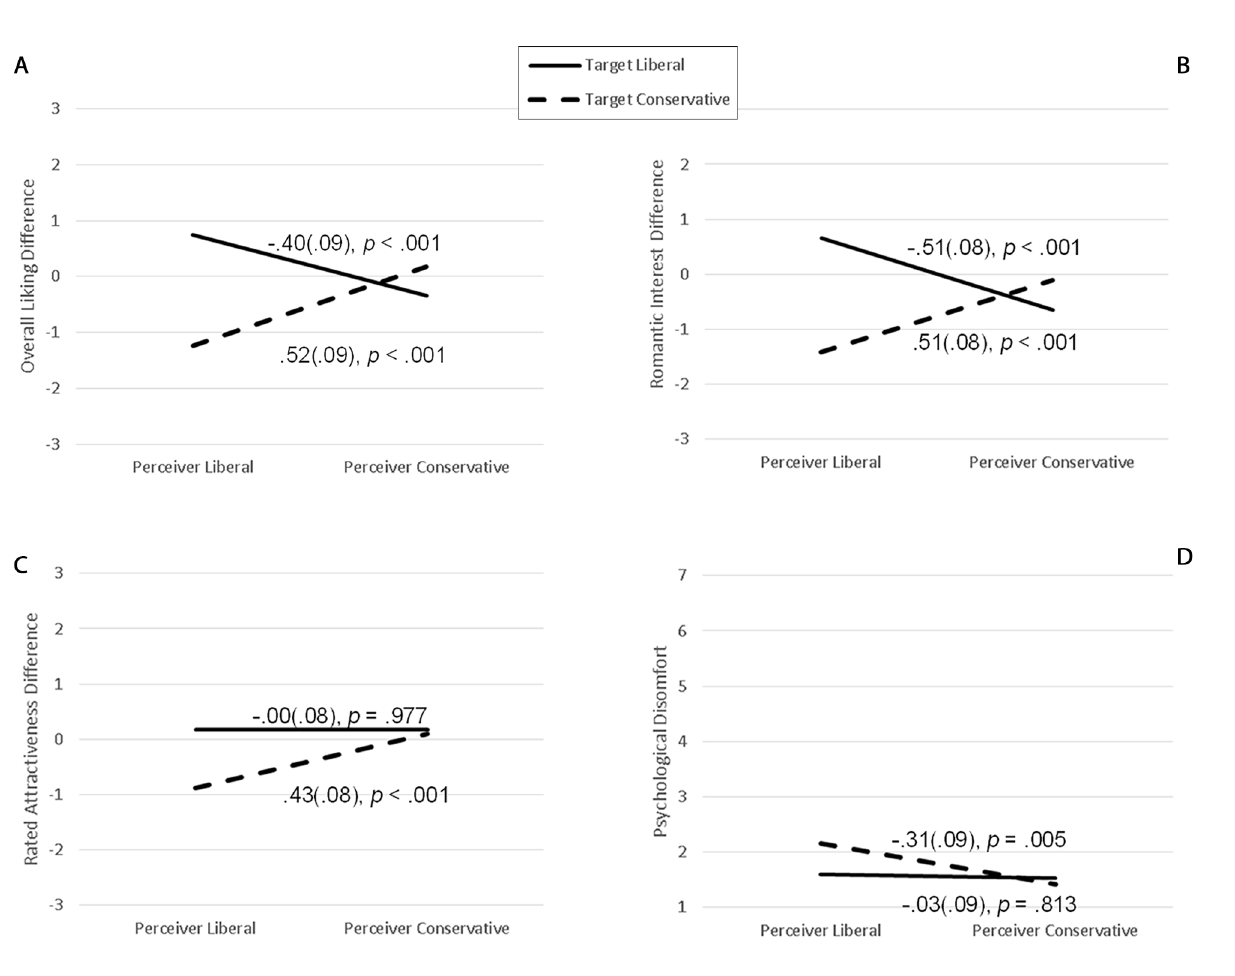
Figure 1. Target Ideology × Perceiver Ideology interactions on dependent variables for Study 1. Standardized regression coefficients are reported for simple slopes and numbers in parentheses represent standard